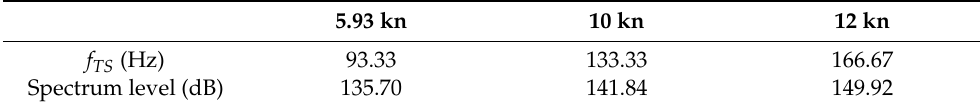
Table 5. The parameters of the T–S wave at different